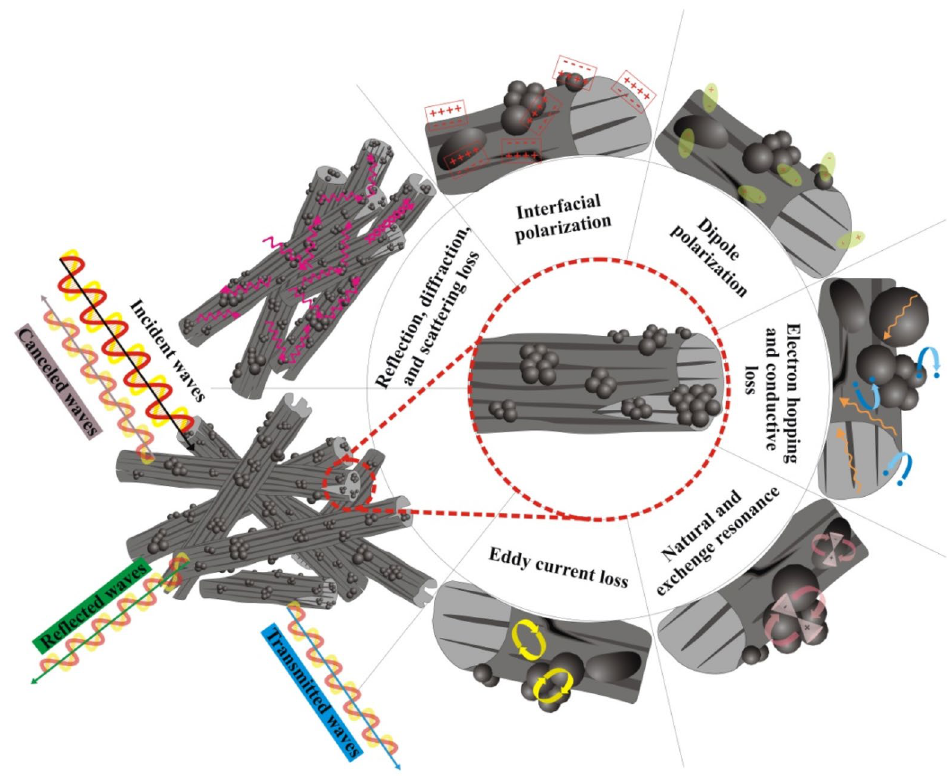
Figure 13. Schematic illustration of the microwave absorbing mechanisms.